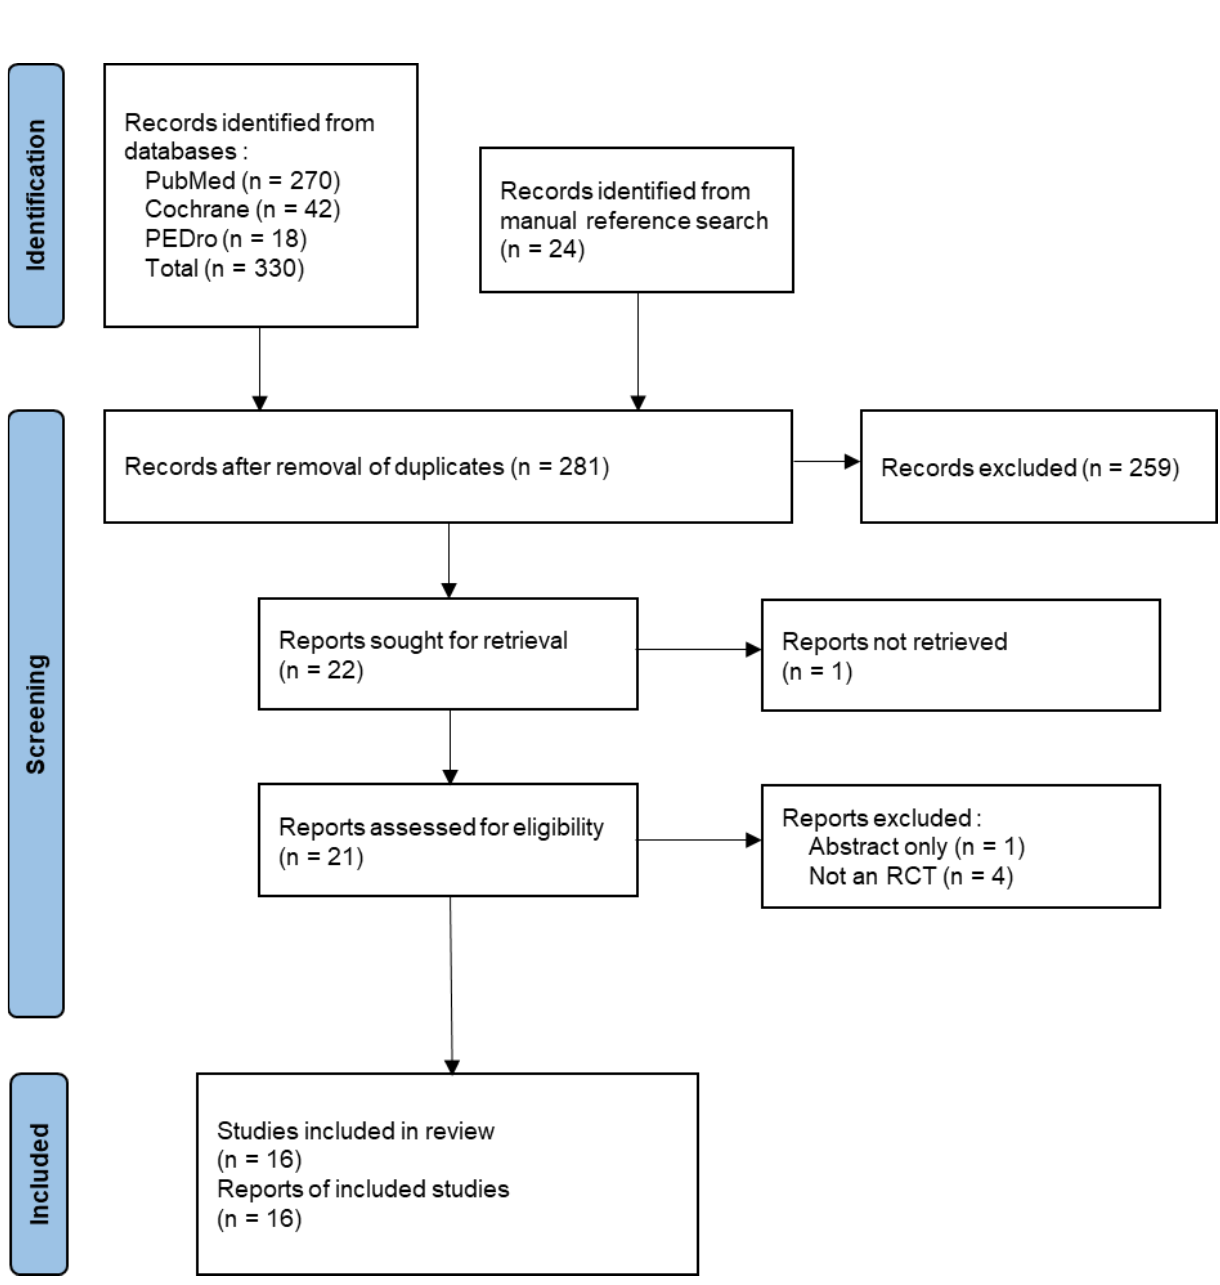
Figure 1. PRISMA Flowchart of the search and selection of the articles.